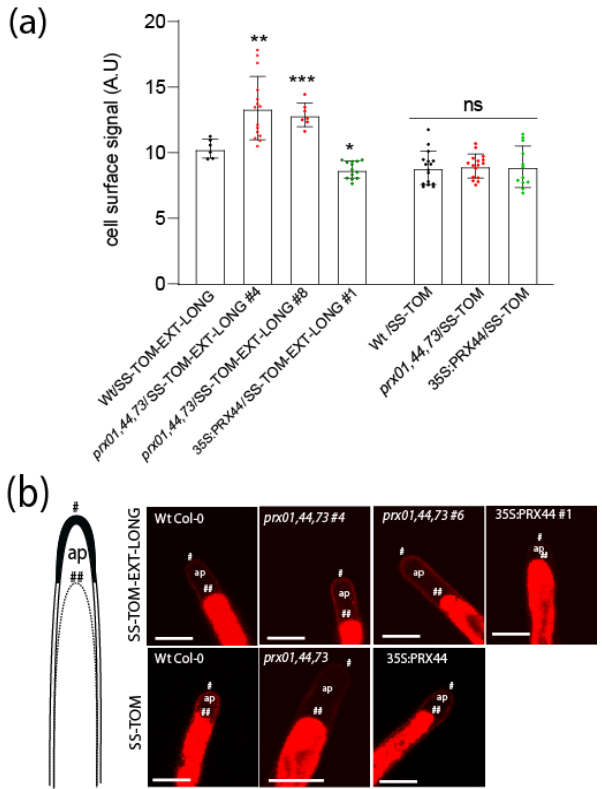
Figure 4. EXT reporter stabilization in root hair apical cell wall depends on PRX01, PRX44, and PRX73. ( a ) Signal of SS-TOM and SS-TOM-EXT-LONG in the apical zone of root hairs in Wt (Col-0), prx01,44,73 triple mutant, and 35S:PRX44 lines. Each point is the signal derived from a single root hair tip. Fluorescence AU data are the mean ± SD (N = 10 root hairs), two-way ANOVA, followed by a Tukey–Kramer test; (*) p < 0.05, (**) p < 0.01, (***) p < 0.001. Results are representative of two independent experiments. Asterisks on the graph indicate significant differences between genotypes. NS = non-significant differences. ( b ) In the images: (*) indicates cell surface, including the plant cell walls, (**) indicates the retraction of the plasma membrane, (ap) apoplastic space delimitated between the plant cell wall and the retracted plasma membrane. Scale bars = 15 μ m.